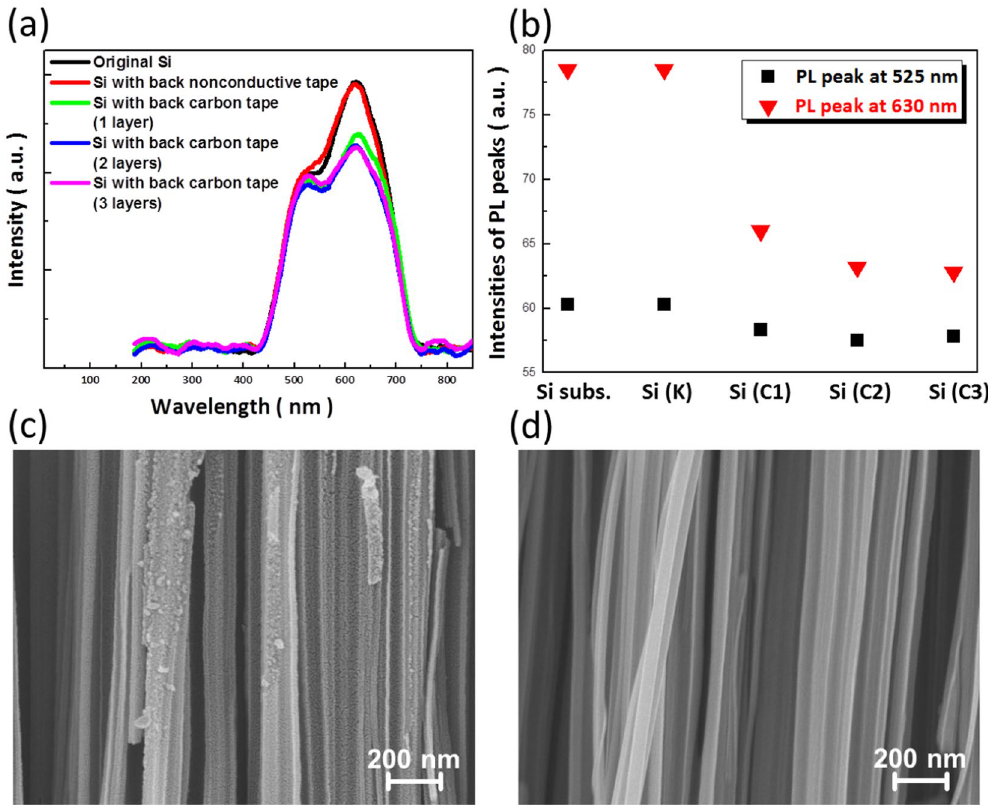
Figure 4. ( a ) PL spectra and ( b ) intensities of two pronounced PL peaks from Si nanowire arrays prepared with conducting MaCE process on various types of Si substrates. High-magnification SEM images of Si nanowires fabricated by ( c ) conventional MaCE and ( d ) back-substrate assisted MaCE with three layers of conductive carbon tape as back